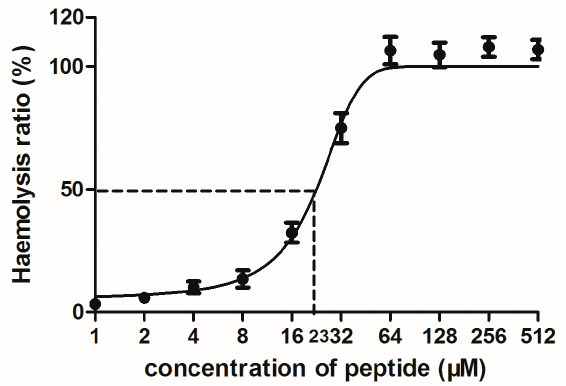
Figure 8. Haemolytic activity of PSN-PC. Percentage of haemolysis was calculated in comparison to the positive control using TritonX-100.